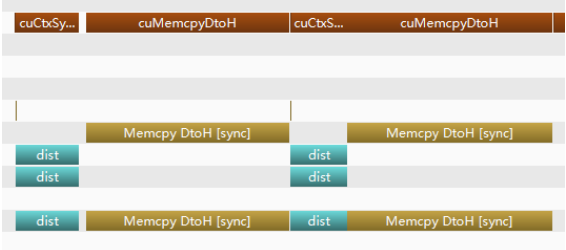
Fig. 2. Performance profile of serial kernels on calculating distance matrices from NVIDIA Visual Profiler.